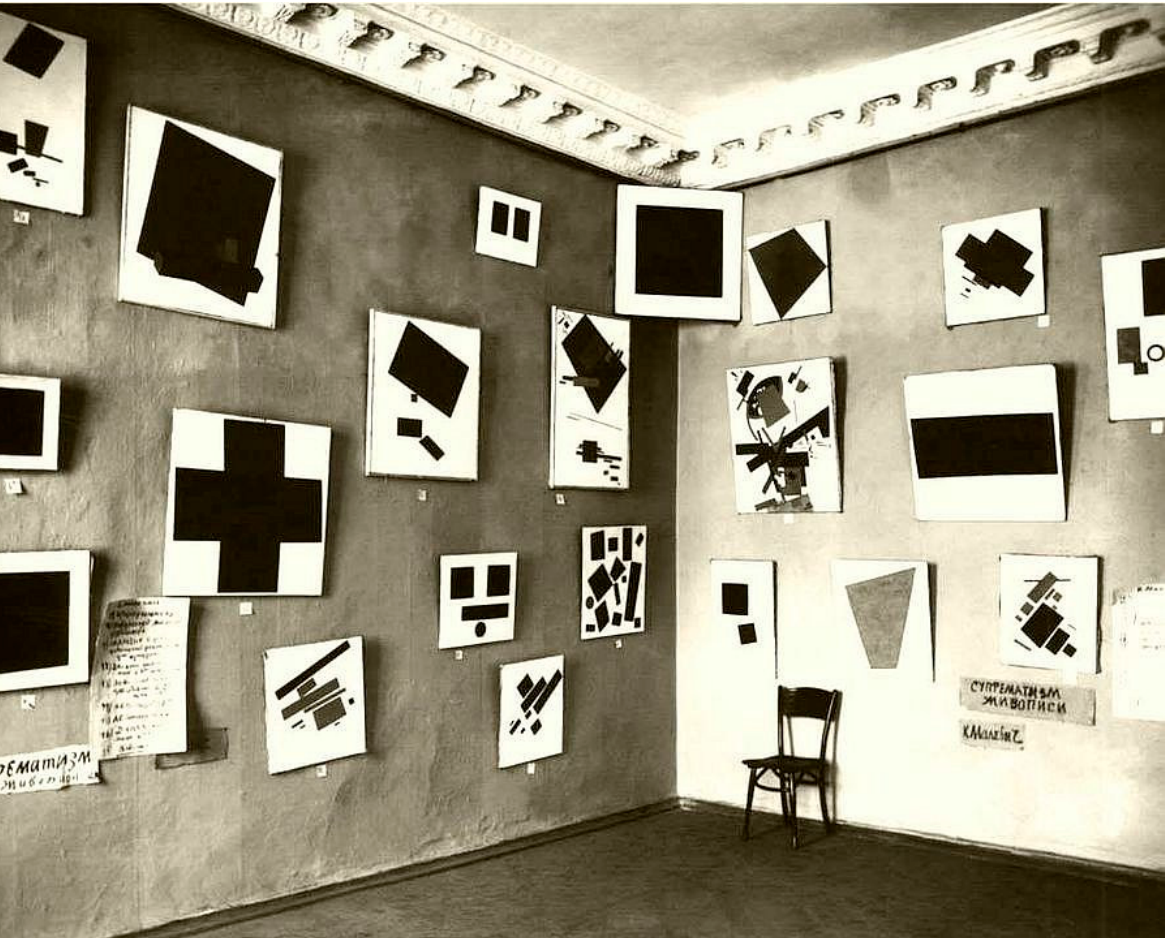
Figure 14. Kazimir Malevich. Black Square as the Divine Child-King ( Tsarstvennyi Mladenets ) at the Head of one of the first Avant-garde exhibitions in Petrograd. December 1915.